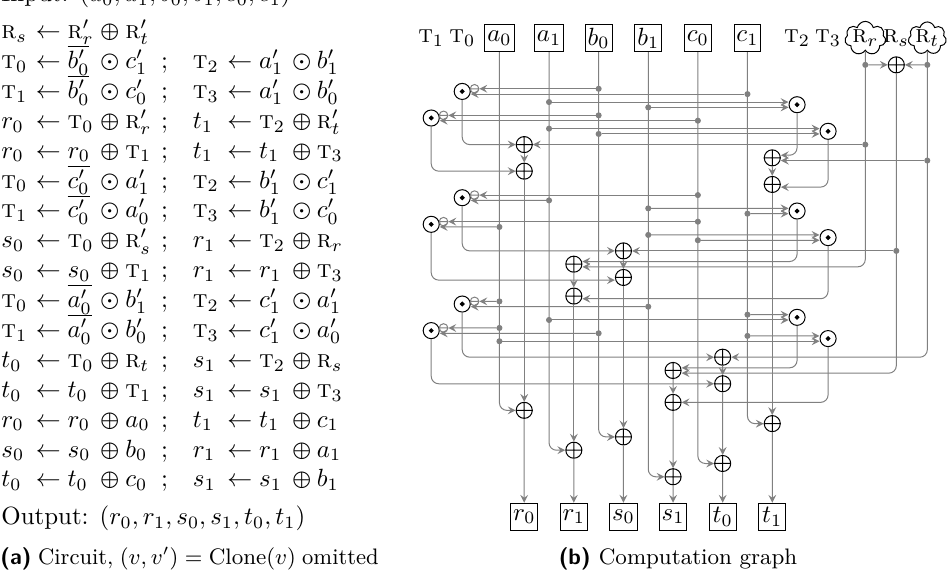
Figure 5: Single-fault SIFA-resistant χ 3 using 2 shares, with global